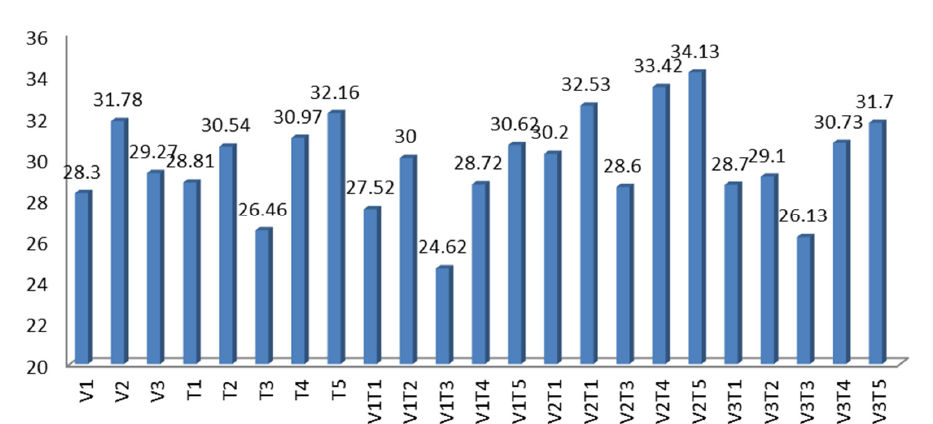
Figure 1. Response of sweet orange cultivars, time of T-budding and interactions on days to